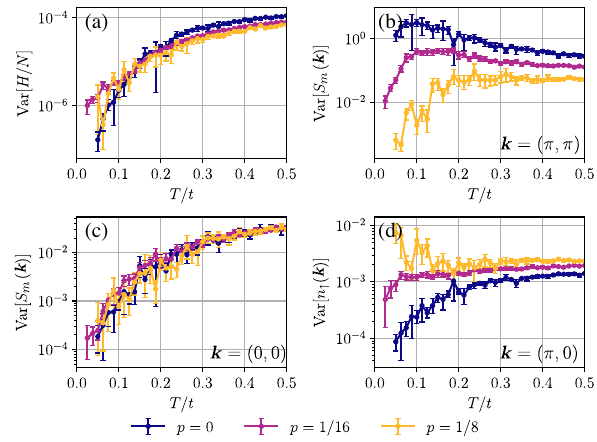
FIG. 18. Variance of time series of METTS measurements for U=t ¼ 10 for hole dopings p ¼ 0 ; 1 = 16 ; 1 = 8 on a 32 × 4 3000 and cylinder. We use time-evolution parameters D max ¼ ε ¼ 10 − 6 . Error bars indicate a 95% confidence interval. (a) En- ergy measurements. We observe a fast decrease of the variance as lowering temperature. (b) Magnetic structure factor S ð k Þ at ordering vector k ¼ ð π ; π Þ . (c) Magnetic structure factor S ð k Þ at ordering vector k ¼ ð 0 ; 0 Þ . (d) momentum distribution function n ð k Þ at reciprocal vector k ¼ ð π ; 0 Þ